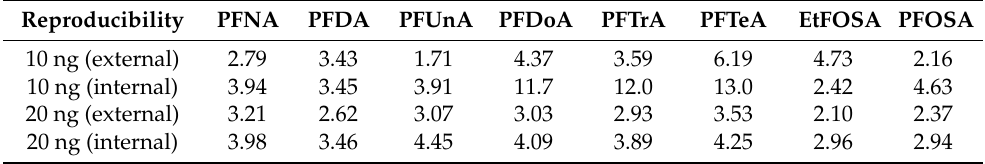
Table 3. Inter-day method precision (reproducibility; fortification amounts: 10 and 20 ng, RSD %, N = 4, k = 2 days) for PFNA, PFDA, PFUnA, PFDoA, PFTrA, PFTeA, EtFOSA, and PFOSA, presented based on the external and internal standard